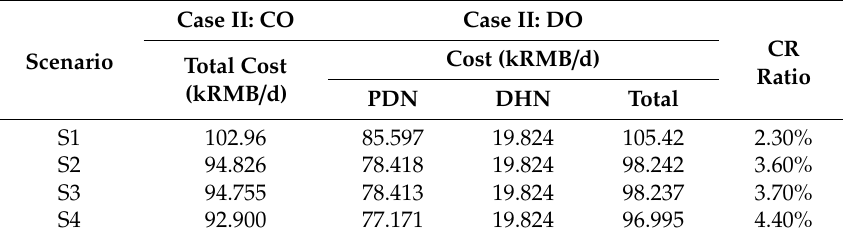
Table 1. Comparison of Operation Costs in Different Cases.